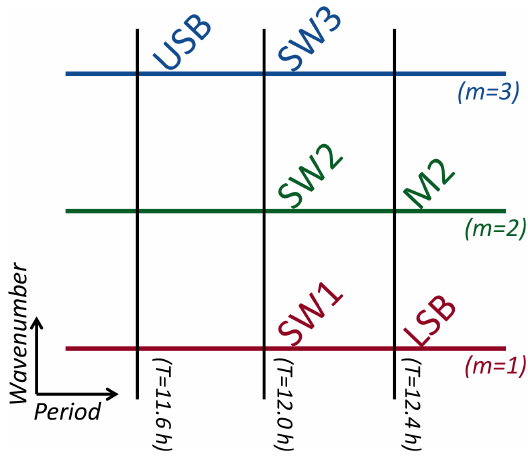
Figure 1. Distribution of near-12h waves in the frequency and zonal wave number space (adapted from He et al., 2018a). In the current study, the colors red, green, and blue represent waves with zonal wave numbers m = 1, 2, and